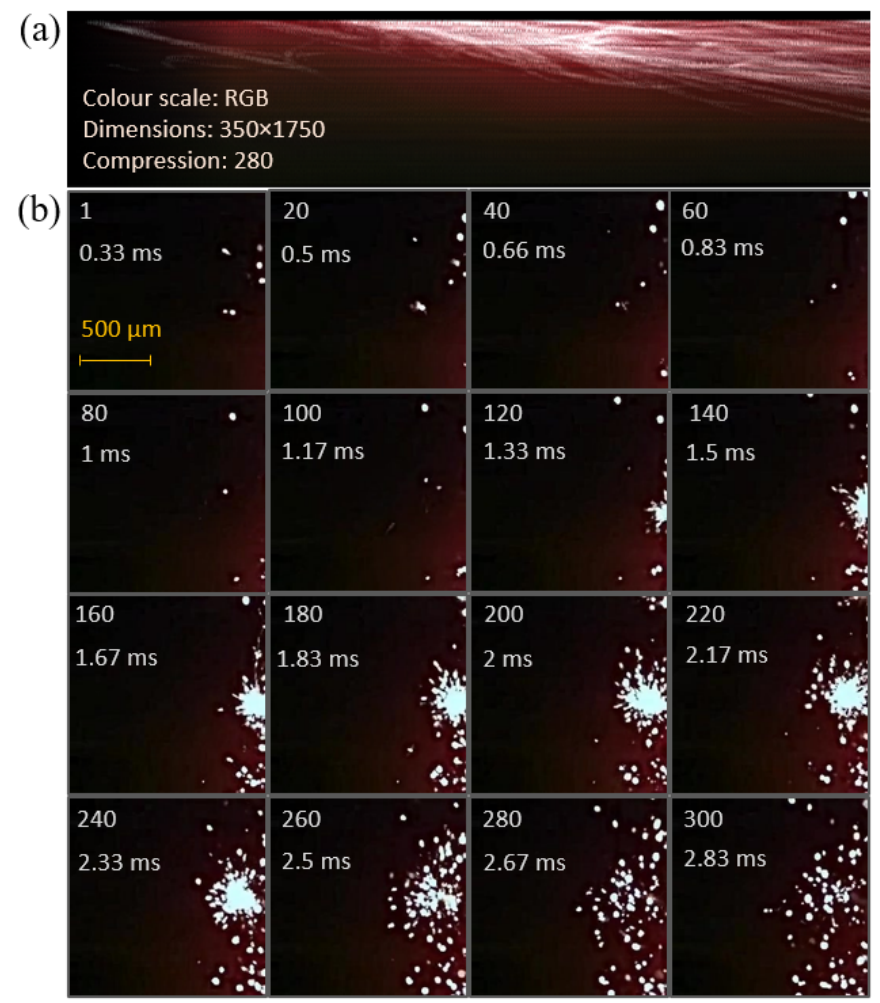
Figure 4. ( a ) Capture of the generated sparks from the lighter at 120 Kfps and ( b ) reconstructed frames from the Captures at frame rate of 120 Kfps. Frame numbers and the time instance of the frames are depicted in the top left corners of each